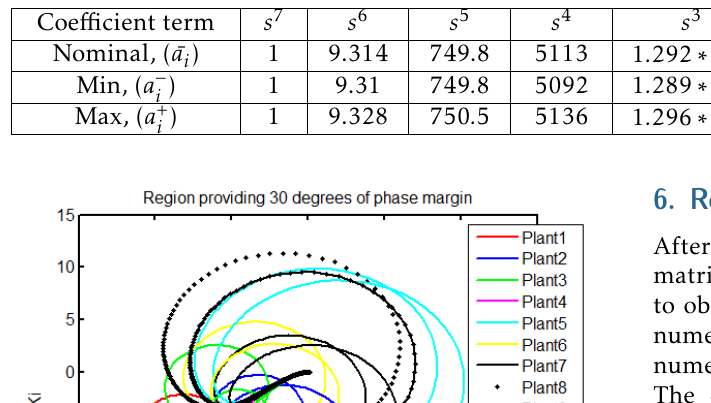
Table 3. Coefficients associated with denominator polynomials.